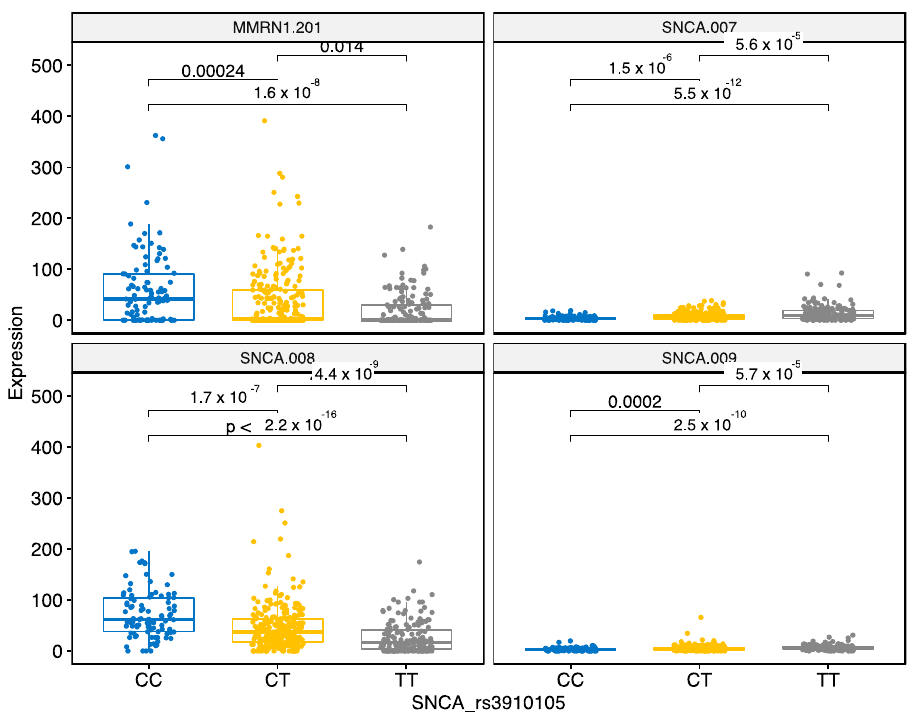
Figure 8. Different genotypes of the SNP rs35910105 (CC, CT or TT variants) differentially regulate expression of three SNCA transcripts and MMRN1. The bars indicate pairwise comparisons and respective p -values after the Wilcoxon test.